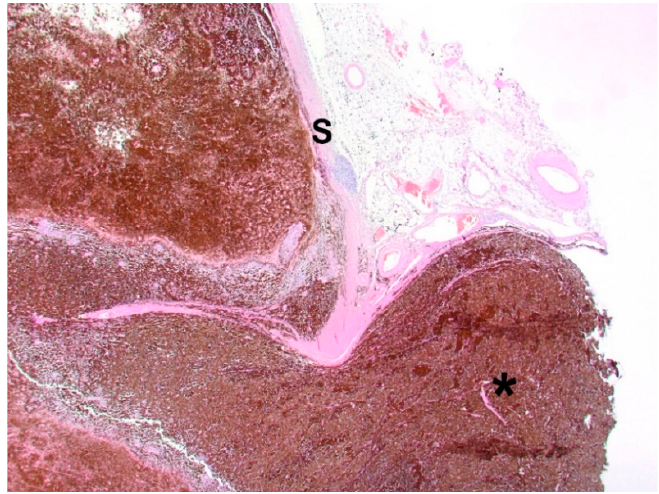
Figure 5. Choroidal melanocytoma with infiltration of the optic disc and extension along the optic nerve (star); S: sclera. Hematoxylin and eosin. 100× magnification.